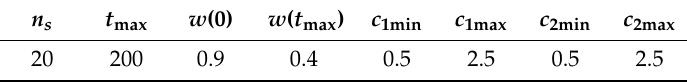
Table 4. User-defined parameters in the PSO